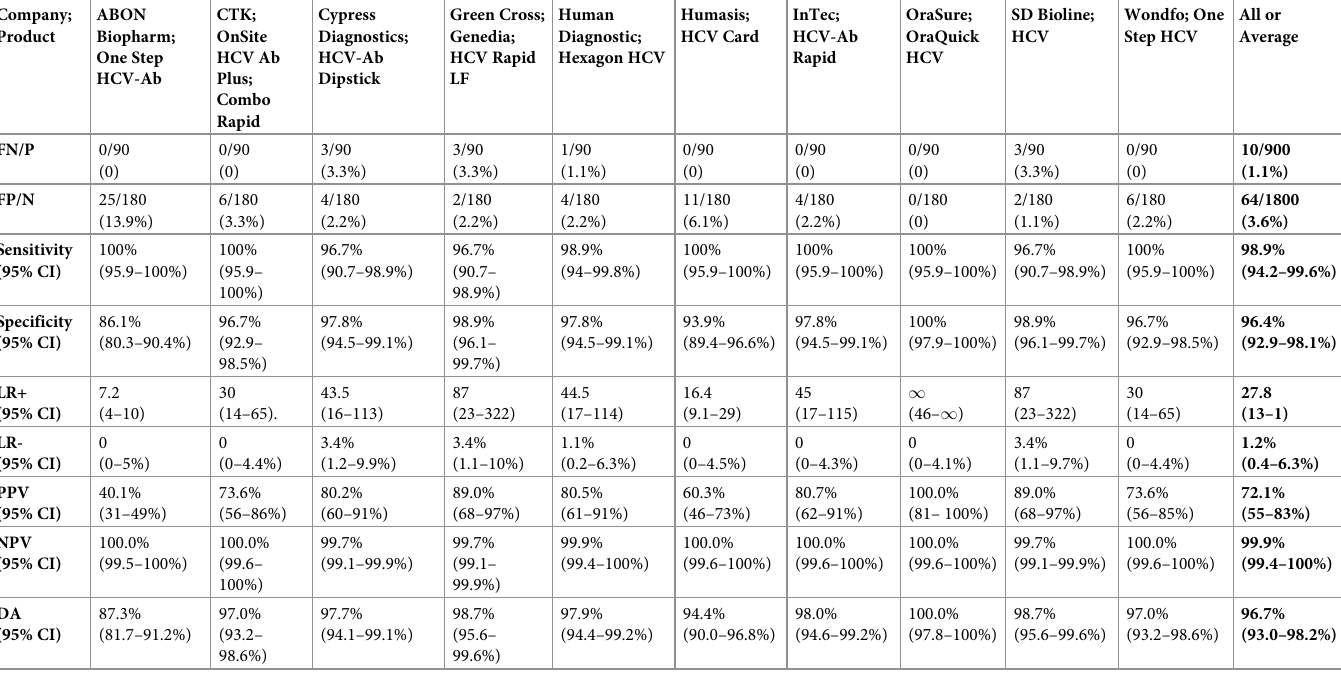
Table 4. Results of RDTs for detection of HCV-Ab in blood serum. For PPV, NPV and DA, an HCV-Ab prevalence of 8.5% was